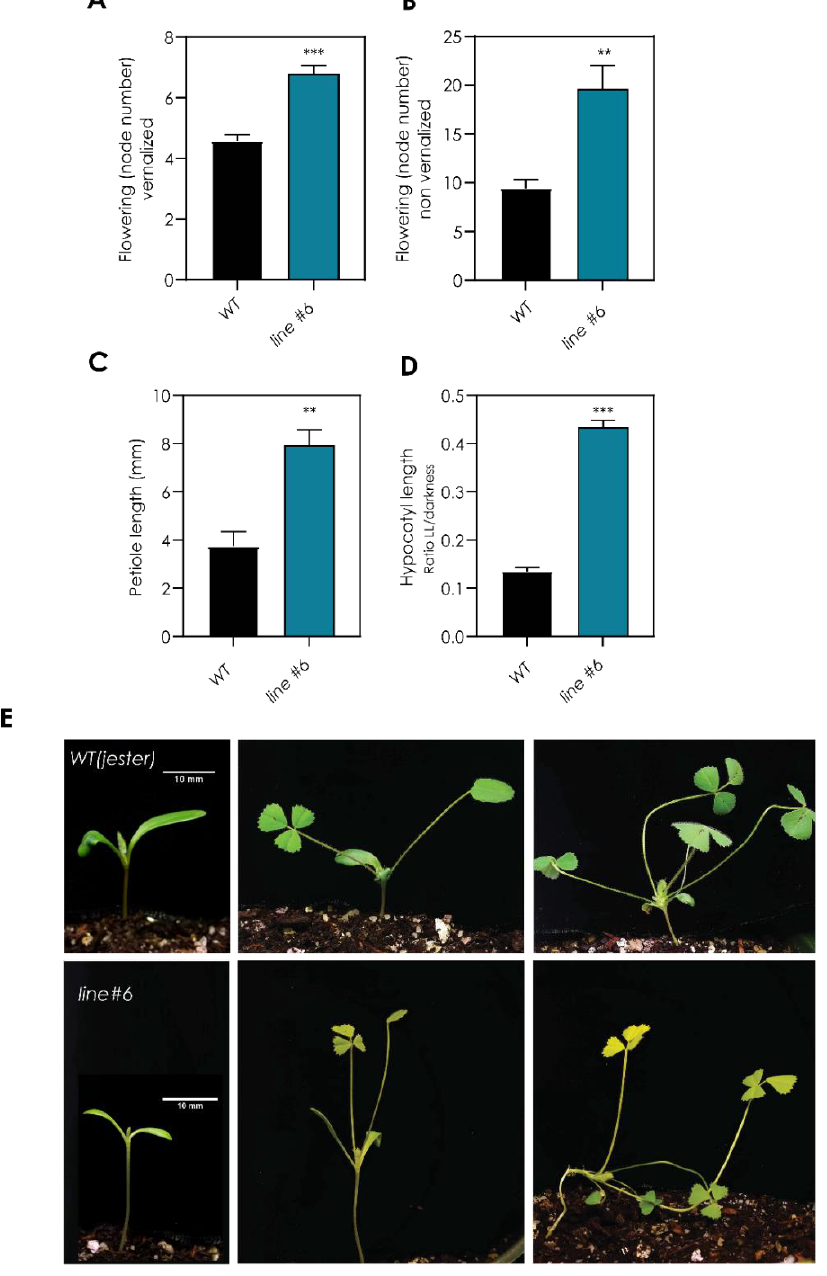
Figure 1. Characterisation of a late flowering mutant ( line#6 ) with light-sensing deficiency. Flowering time of WT (Jester) and line#6 of ( A ) vernalized plants (14d at 4 °C) under LD conditions and ( B ) non-vernalized plants under LD conditions. ( C ) Petiole length (mm) and ( D ) hypocotyl length (ratio LL/dark) under continuous light (LL). ( E ) Photograph of WT (Jester) and line#6 plant at the cotyledon stage, after the expansion of the first trifoliate and after the expansion of the fourth trifoliate leaf produced from the apical meristem. Ruler = 10 mm. ** p < 0.01, *** p < 0.001 (Student t -test). Error bars represent SEM.